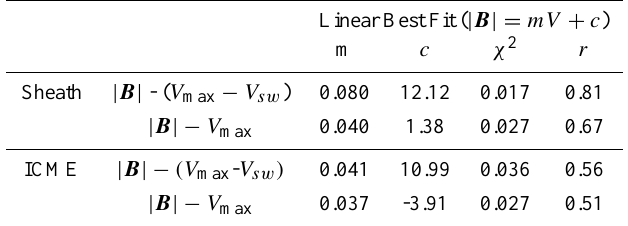
Table 3. The relations between maximum field intensity and maxi- mum speed, and maximum field intensity and maximum speed rel- ative to the upstream solar wind are given for both the sheath region and ICME body for the 35 E-S line ICMEs. The linear best fit pa- rameters (in the form | B | = mV + c ), χ 2 and linear correlation coefficient ( r ) are